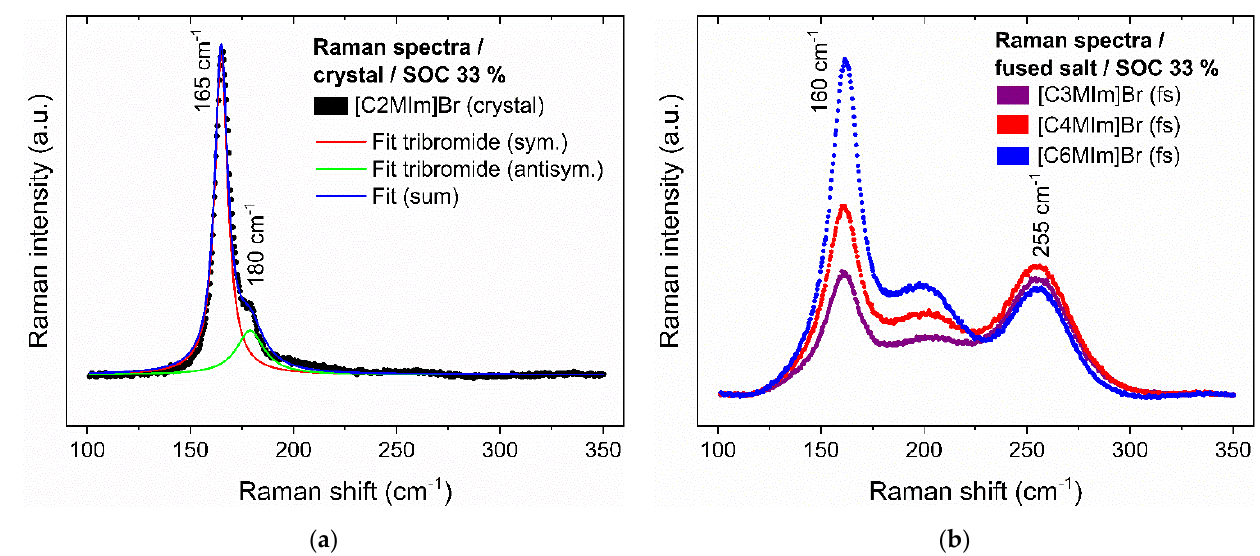
Figure 3. Raman spectra of ( a ) dry crystals of [C2MIm]Br 3 including peak fitting for Raman shifts at ṽ = 165 cm − 1 and ṽ = 180 cm − 1 and ( b ) liquid fused salts of [C3MIm]Br 2n+1 , [C4MIm]Br 2n+1 and [C6MIm] Br 2n+1 at θ = 23 ± 1 °C each at an SoC of 33% (c(HBr) = 5.47 M, c(Br 2 ) total = c([BCA]Br = 1.11 M).